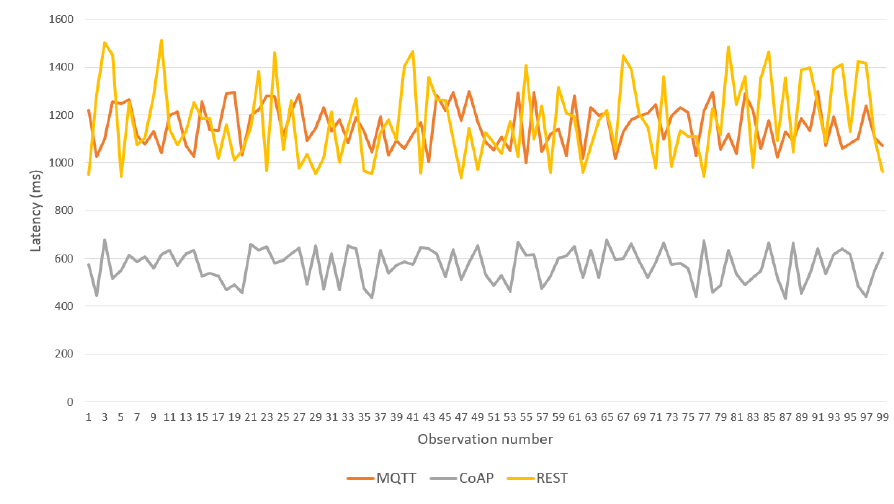
Figure 18. Latencies of binding protocols over LTE (for